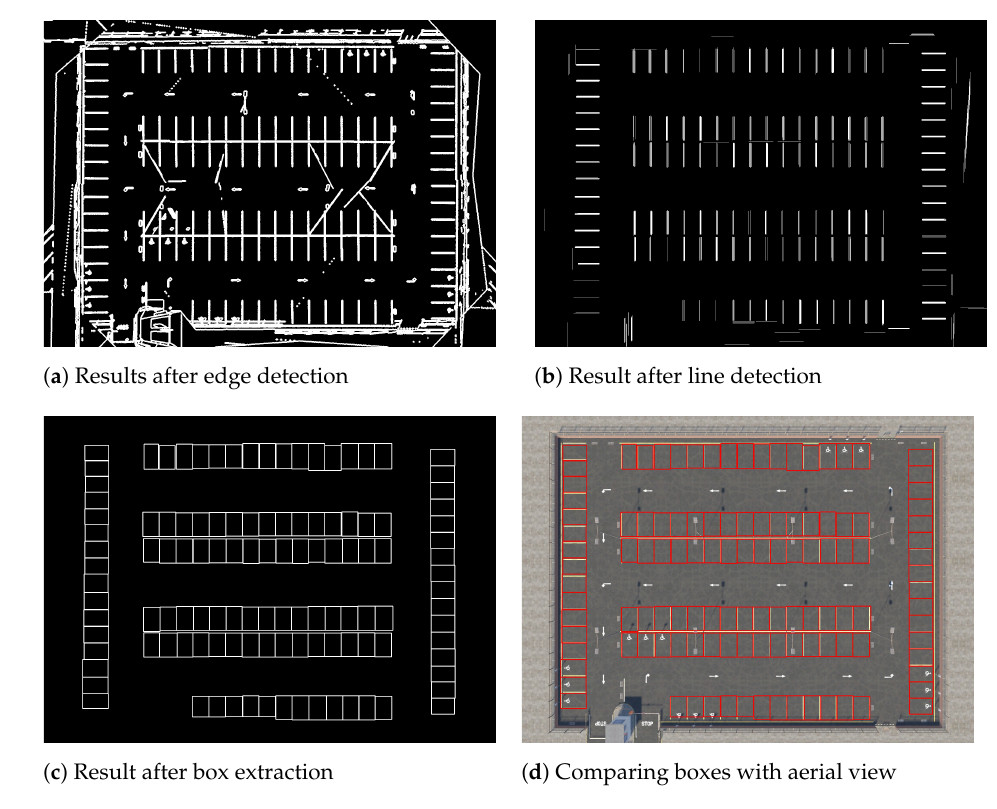
Figure 9. Illustration of parking space extraction. ( a – c ) show the result of each step in parking space extraction. ( d ) shows the comparison of extracted boxes with the real aerial